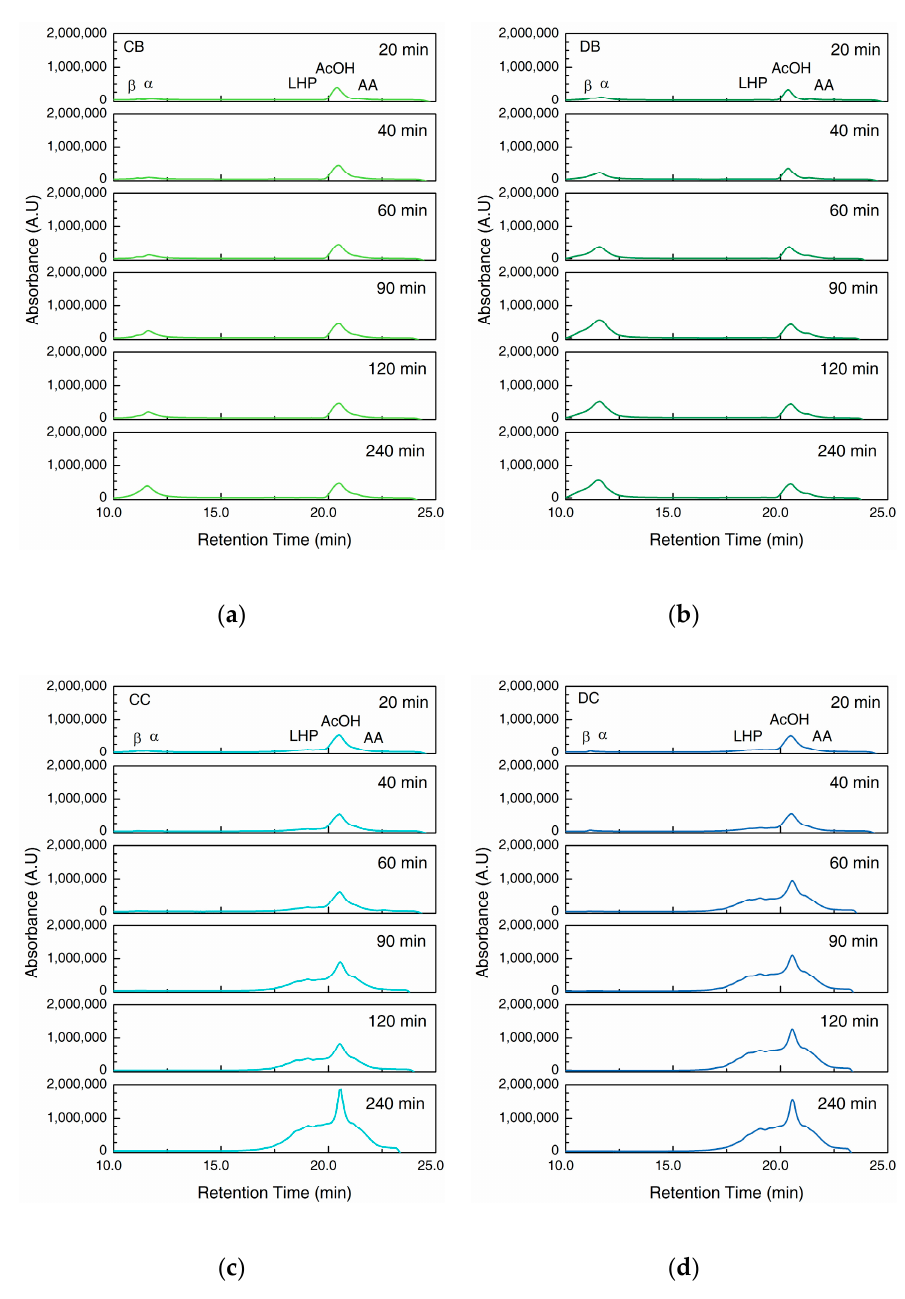
Figure 4. Chromatograms of size-exclusion chromatography (SEC) of supernatants collected at a wavelength of 210 nm. ( a ) C-coll hydrogel in Tris buffer, pH 7.4 (CB); ( b ) D-coll hydrogel in Tris buffer, pH 7.4 (DB); ( c ) C-coll hydrogel in collagenase solution in Tris buffer, pH 7.4 (CC) and ( d ) D-coll hydrogel in collagenase solution in Tris buffer, pH 7.4 (DC). Peaks are labelled as: β = collagen β chains; α = collagen α chains; LHP = low molecular weight hydrolyzed peptides; AcOH = acetic acid; AA = amino acids.